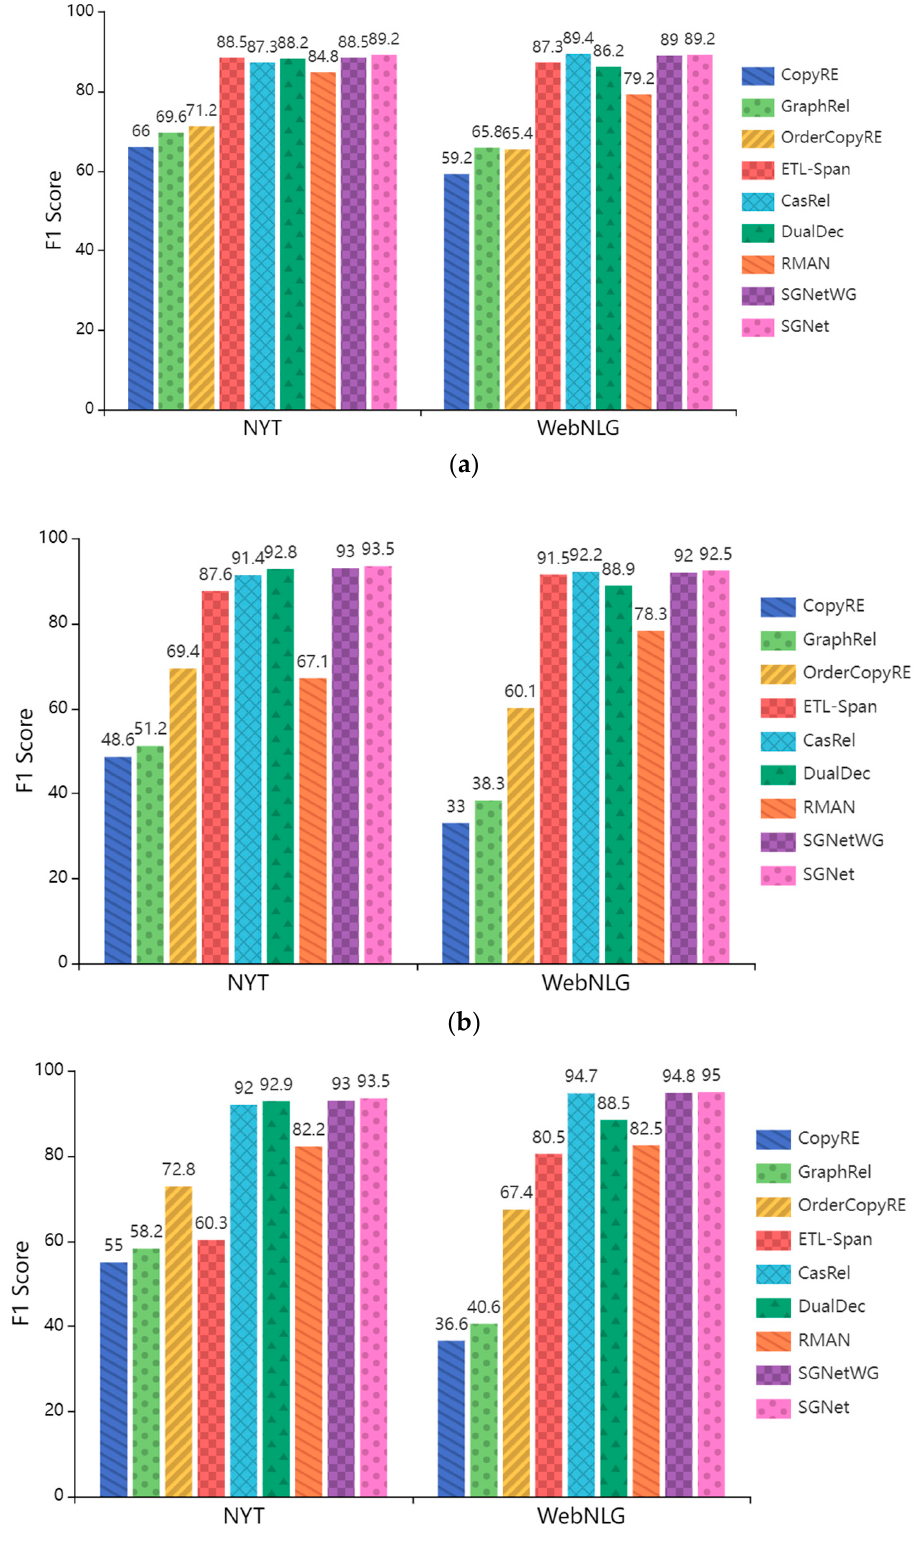
Figure 5. F1 score of extracting relational triples from sentences with the different overlapping patterns. ( a ) F1 of Normal Class, ( b ) F1 of SEO Class, ( c ) F1 of EPO Class.